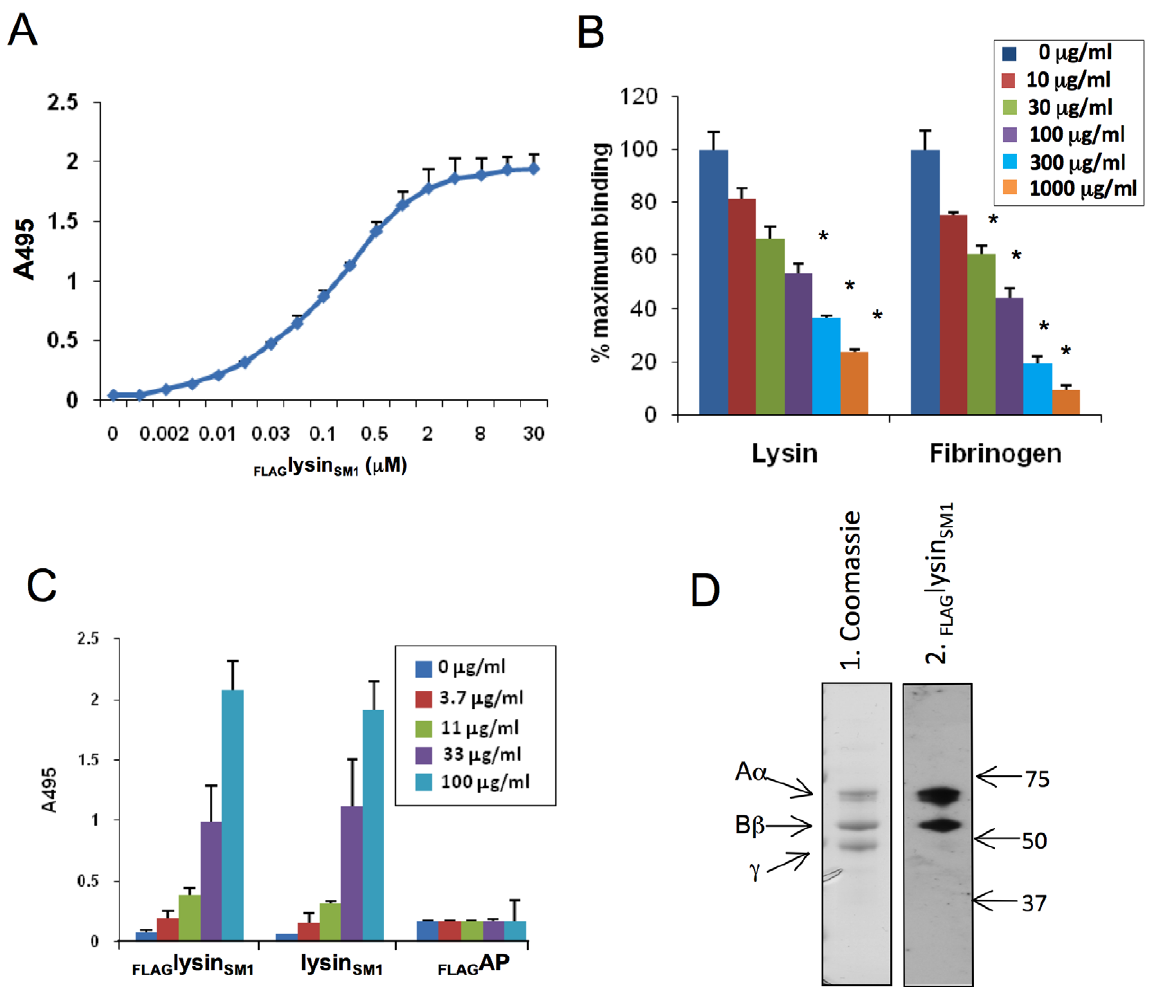
Figure 4. Lysin-fibrinogen binding. (A) Binding of FLAG lysin SM1 to immobilized human fibrinogen. X-axis indicates concentration of FLAG lysin SM1 incubated with fibrinogen. (B) Inhibition of FLAG lysin SM1 binding to immobilized fibrinogen by unlabelled lysin SM1 or fibrinogen. The binding of FLAG lysin SM1 (3 m g/ml) to immobilized fibrinogen was tested in buffer containing 0 to 1,000 m g/ml of lysin SM1 or fibrinogen. * = P , 0.05, as compared with 0 m g/ml. (C) Fibrinogen binding to immobilized FLAG lysin SM1 , unlabelled lysin SM1 , or FLAG AP. Concentrations indicate amount of protein added. Bars are the means ( 6 S.D.) of triplicate results from a representative experiment. (D) Binding of FLAG lysin SM1 to fibrinogen by far Western blotting. Fibrinogen was separated by SDS-PAGE and stained with Coomassie blue (panel 1) or transferred to nitrocellulose and probed with FLAG lysin SM1 (panel 2). The three bands detected in panel 1 correspond to A a , B b , c chains of fibrinogen. Numbers indicate molecular mass. Binding of FLAG lysin SM1 to the A a and B b chains was readily observed, but not to the c chain (panel 2).